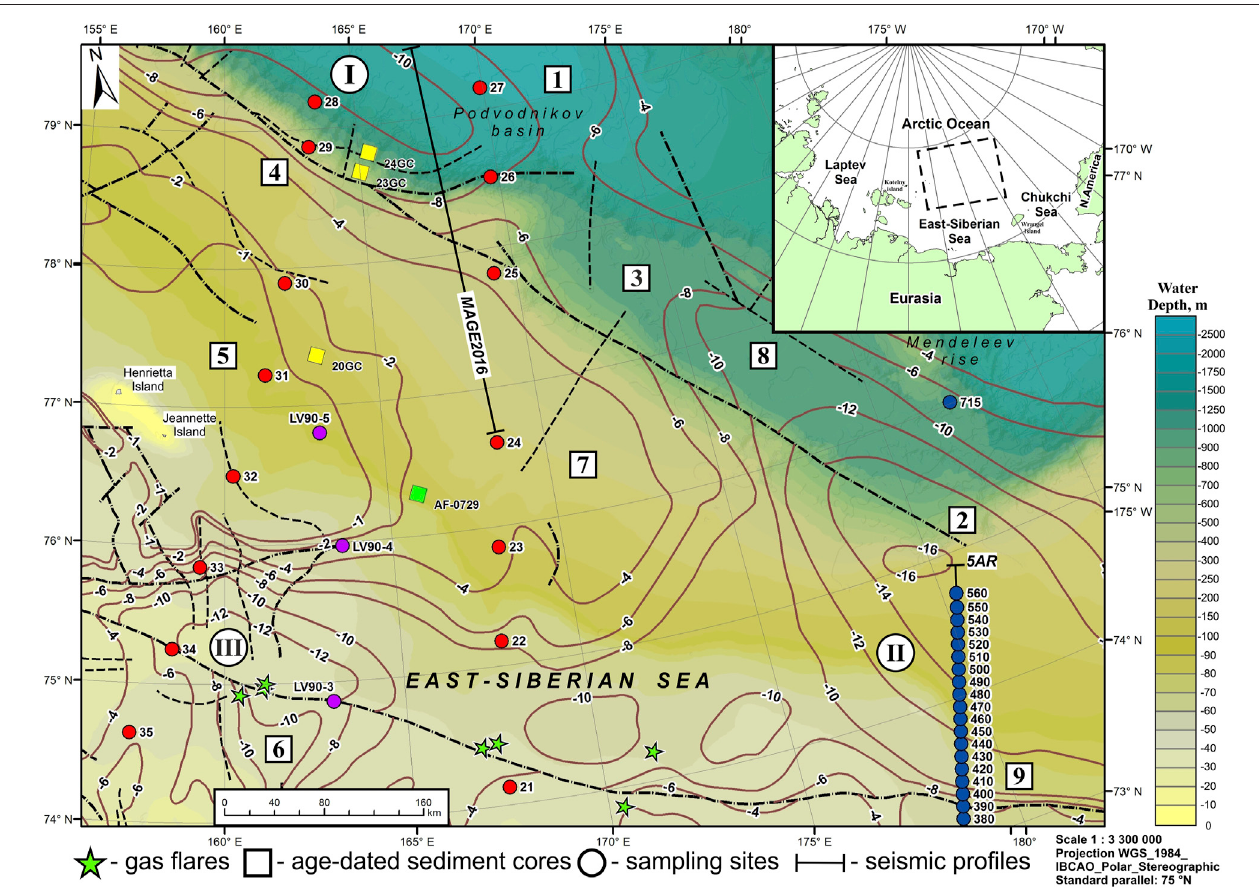
FIGURE1| Structuraltectonicmapoftheresearchareawithisolinesshowingsedimentarycoverthicknessinkilometer(AfterGeologicalMap,2015andGeological Map of Russian Federation and Adjacent Waters, 2016) and bathymetry from IBCAO version 3.0 (Jakobsson et al., 2012). Sedimentary basins are as follows I) Cis-East Siberian, II) North Chukchi, and III) Novosibirsk. Geological structures are as follows: 1) Vilkitsky Depression West, 2) North Chukchi Depression, 3) Kucherov uplift, 4) Lomonosov – Mendeleyev fl exure – faults zone, 5) De Long uplift, 6) Novosibirsk Depression, 7) North structural terrace, 8) Vilkitsky Depression East, and 9) Kolyuchinsky graben-rift. Position of observed gas fl ares (green stars) is from Thornton et al. (2020). The location of age-dated sediment cores (square) is from O ’ Regan etal.(2017),yellowsquare;andGeologicalMap(2015),greensquare.Gasgeochemicalsamplingsites(circle)weresampledin2008(LV45),bluecircle;2017(LV77),red circle, and 2020 (LV90), violet circle. Seismic pro fi les: 5AR from Sakulina et al. (2011) and MAGE 2016 from Kazanin et al. (2017a).